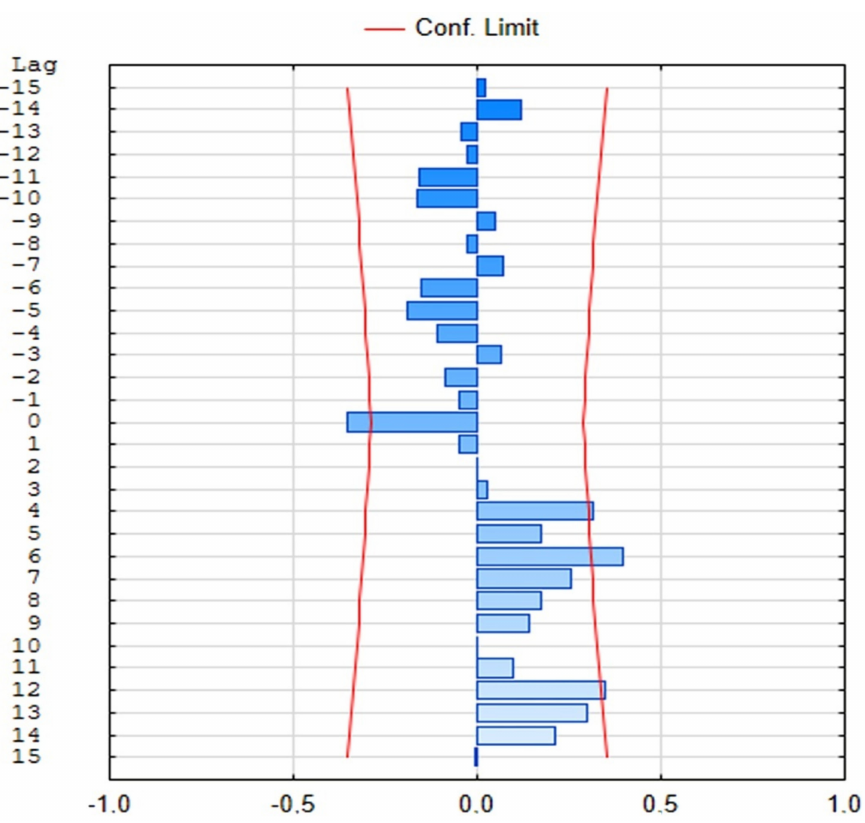
Figure 4. Cross-correlation of the abundance of Ixodex apronophorus and its mammal hosts in the Tyumen Region, West